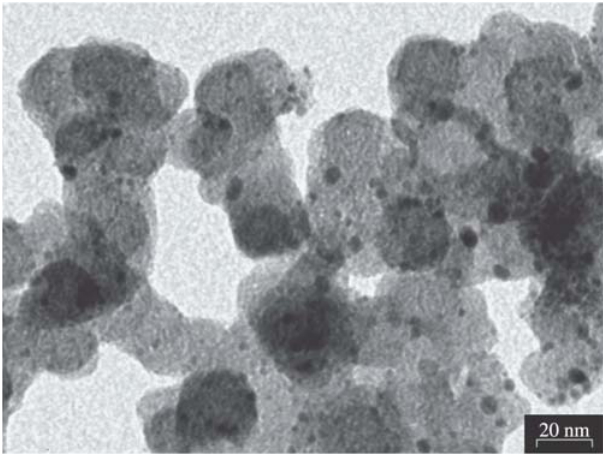
Figure 3. Nanocrystals of PtRu (SD) electrocatalyst dispersed in the carbon matrix. The crystallites have a bimodal distribution with an average size of 2.5 ± 0.4 nm and 5.2 ± 1.2 nm.